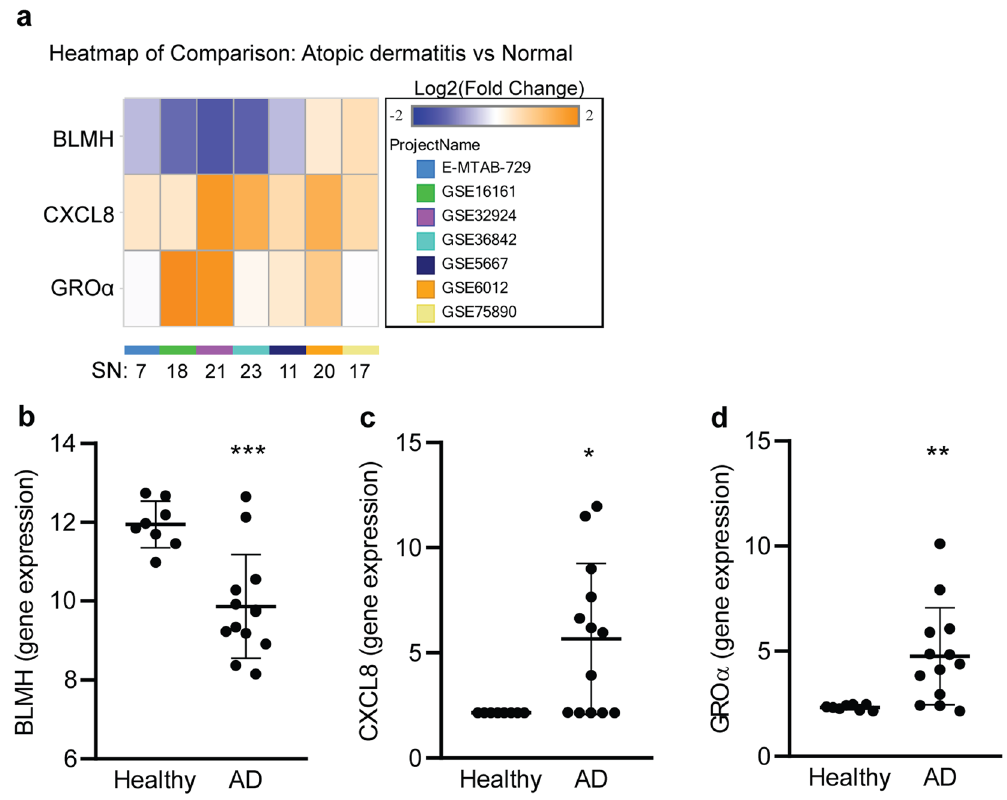
Figure 1. Expression of BLMH is downregulated in skin lesions from AD patients. ( a ) A genomic meta-analysis of gene expression of BLMH, CXCL8 and GRO α in lesions from AD patients versus healthy individuals were conducted covering 7 cohorts with stated sample numbers (SN) of healthy individuals + AD patient samples. The Project named GSE32924 contained the largest number of AD patients and the gene expressions in patients versus healthy skin were compared in graphs ( b – d ) (healthy n = 8, AD n = 13, unpaired two-tailed Student’s t-tests). All values represent individual experiments with mean ± standard deviation. Significant P-values are presented as * p < 0.05; ** p < 0.01; *** p < 0.001 and **** p <